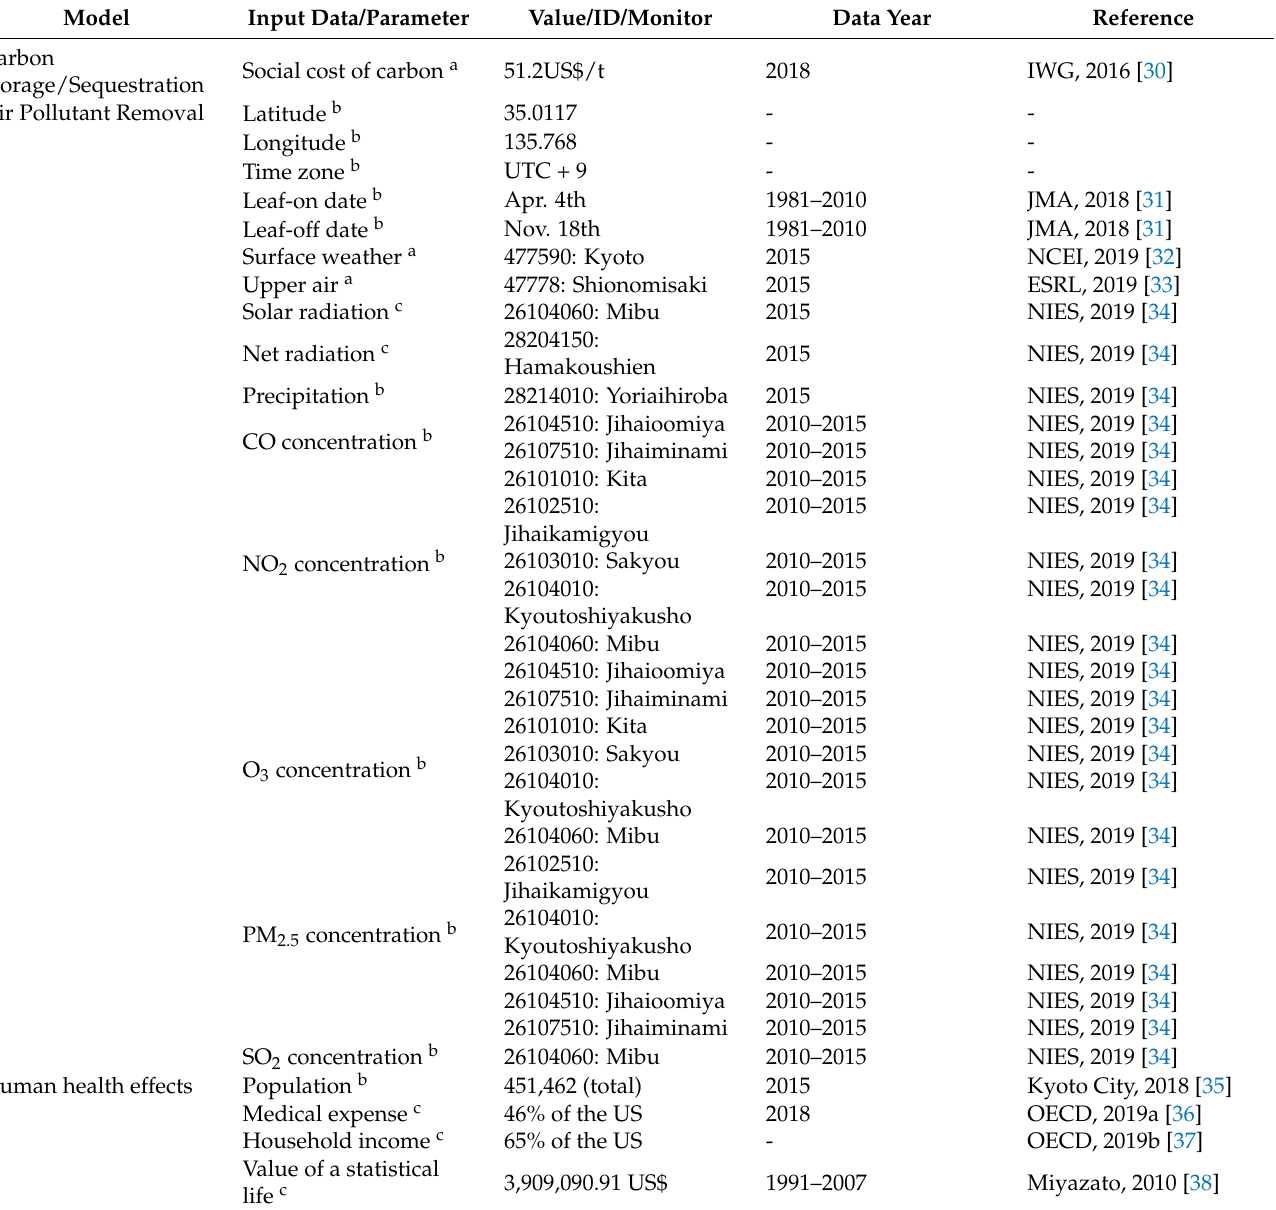
Table 1. Model input data and parameters used for i-Tree Eco run for Kyoto